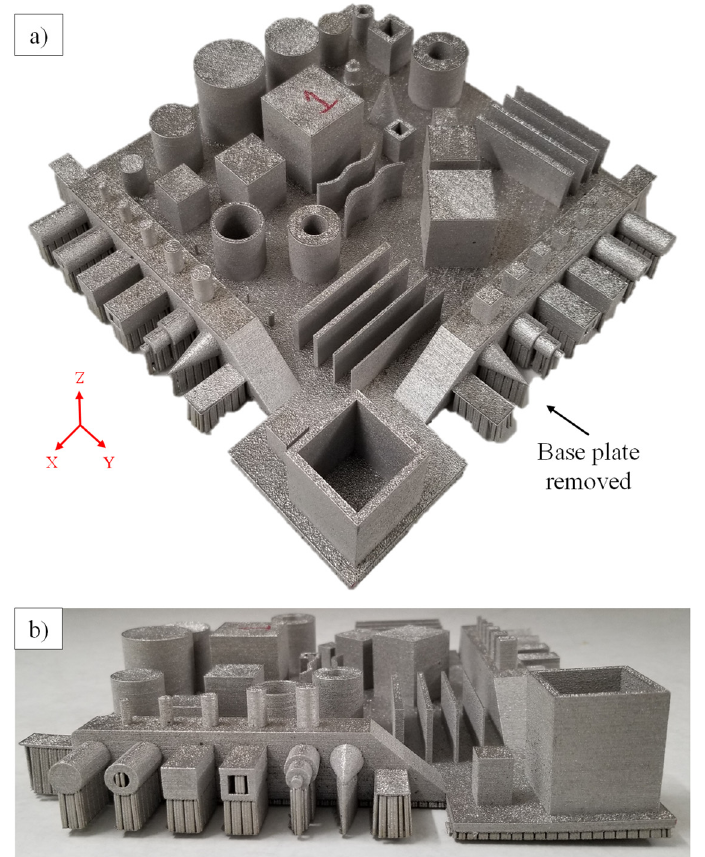
Figure 4. GBTA after the removal of the base plate: ( a ) Isometric view and ( b ) side view showing warped features.